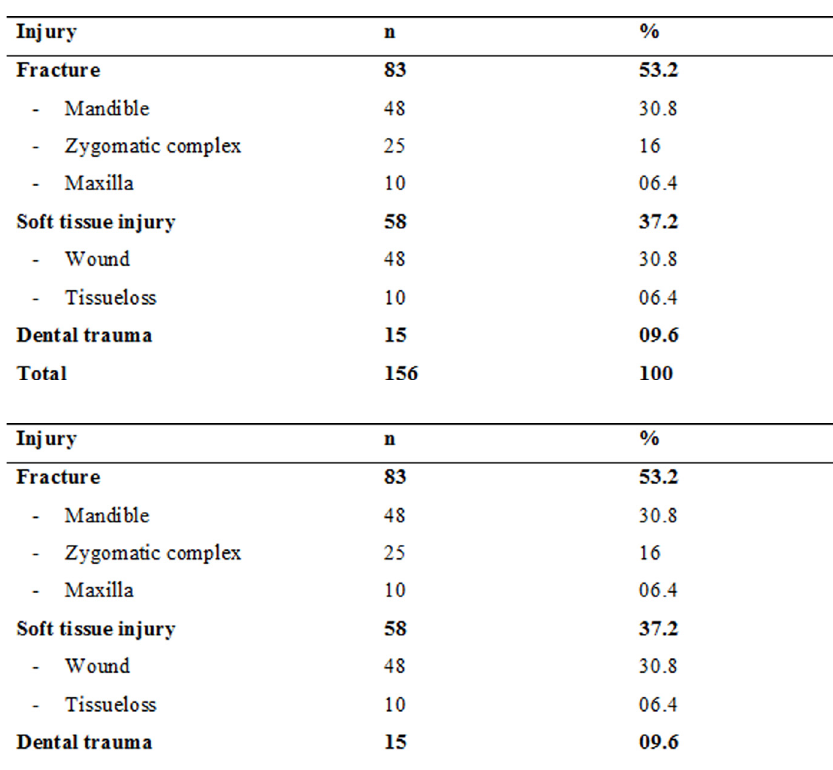
Table II. Facial injury